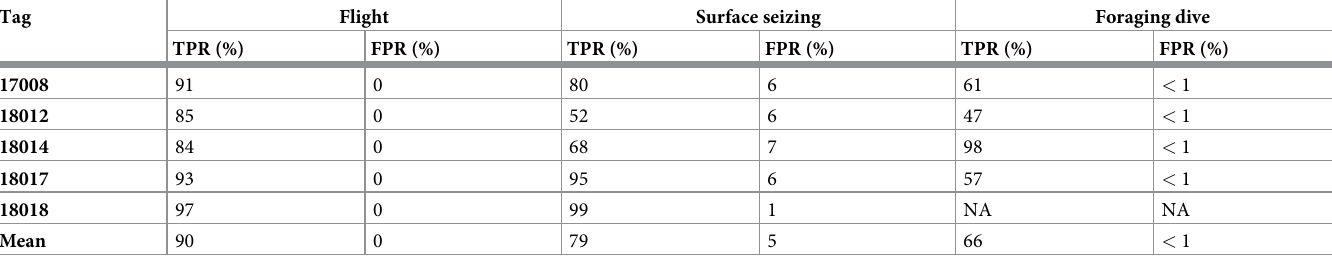
Validation rates (true positive rate, TPR; false positive rate FPR) of estimated behaviours across all video and acceleration